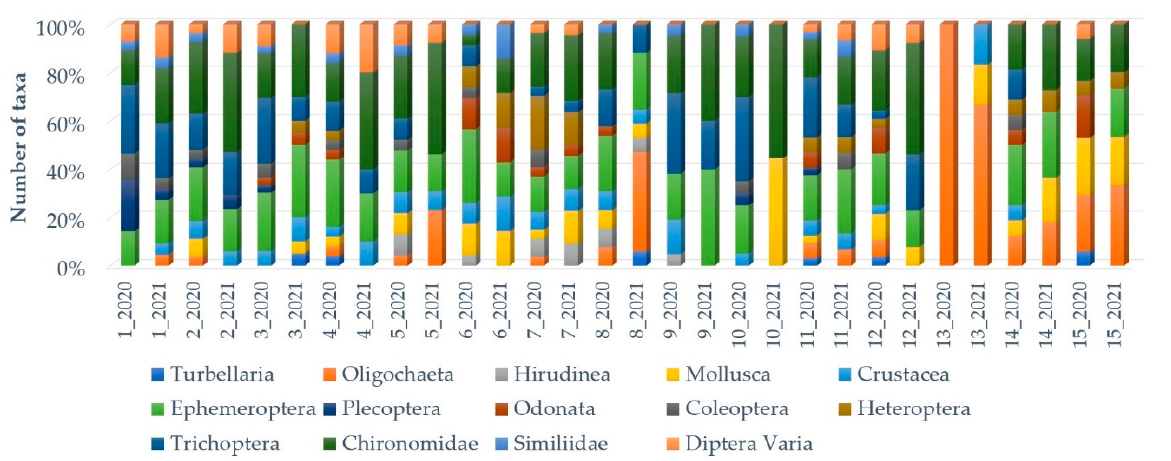
Figure 4. Number of macroinvertebrate taxa and density (ind./m 2 ) at the studied sites. The distribution by main taxonomic groups showed that the order Ephemeroptera was present at almost all studied sites. Representatives of this group were not found at (Figure 5).